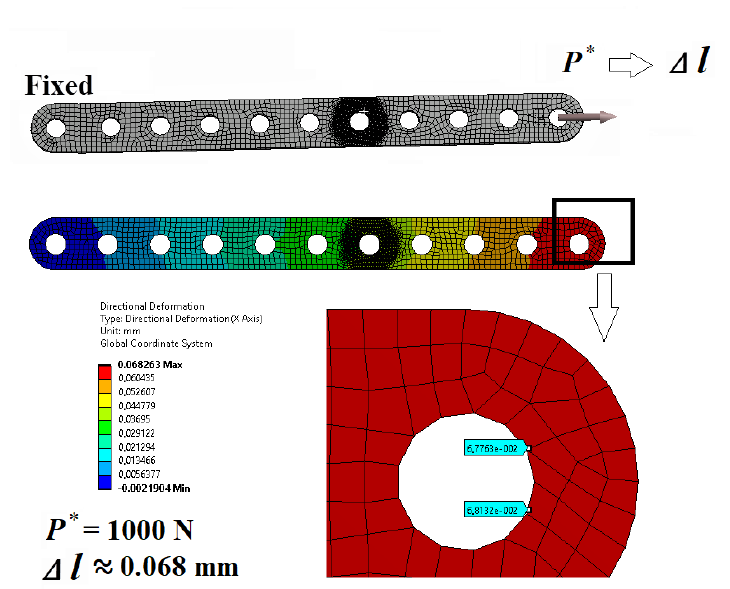
Figure 7. The simulation of the effect of stiffness, see Appendix B, Table A2, Label